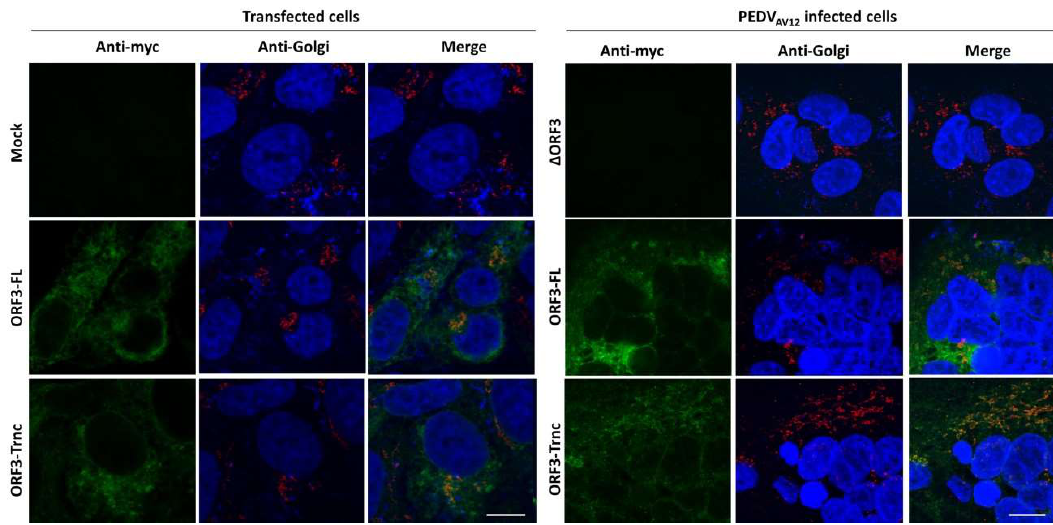
Figure 4. Subcellular localization of ORF3s in the Golgi apparatus of transfected and infected VeroE6-APN cells. VeroE6-APN cells were transfected with pCAGGS_ORF3s-myc (ORF3-FL or-Trnc) ( left panel ) or infected by the PEDV AV12 _∆ORF3 and-ORF3s-myc (ORF3-FL or-Trnc) ( right panel ). Cells were stained with rabbit anti-myc and mouse anti-58K Golgi marker as primary antibodies and goat anti-rabbit IgG Alexa flour 488 and-mouse IgG Alexa flour 647 as secondary antibodies. Nuclei were stained with Prolong Gold Antifade Mountant with DAPI. Co-localization of PEDV ORF3 protein with the Golgi marker was analyzed by confocal microscopy. Scale bars are 10 µm.